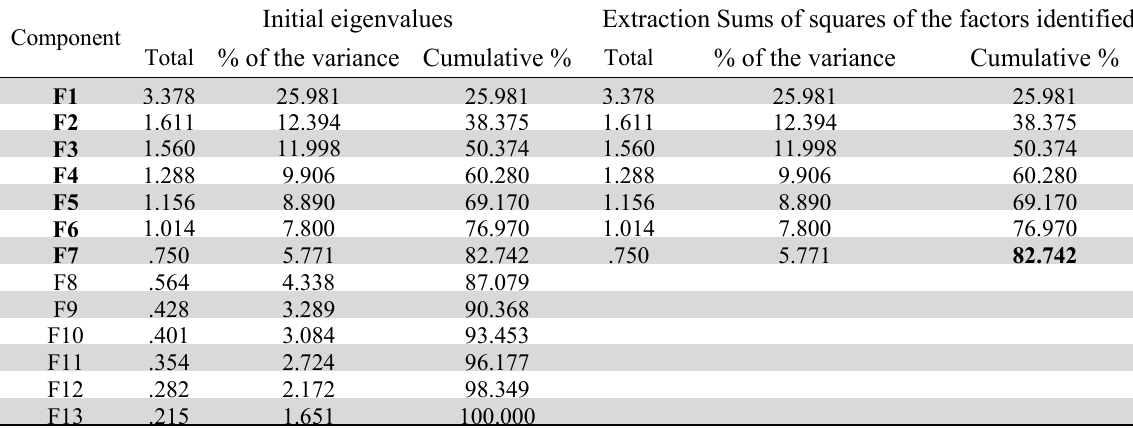
Total variance using factorial analysis